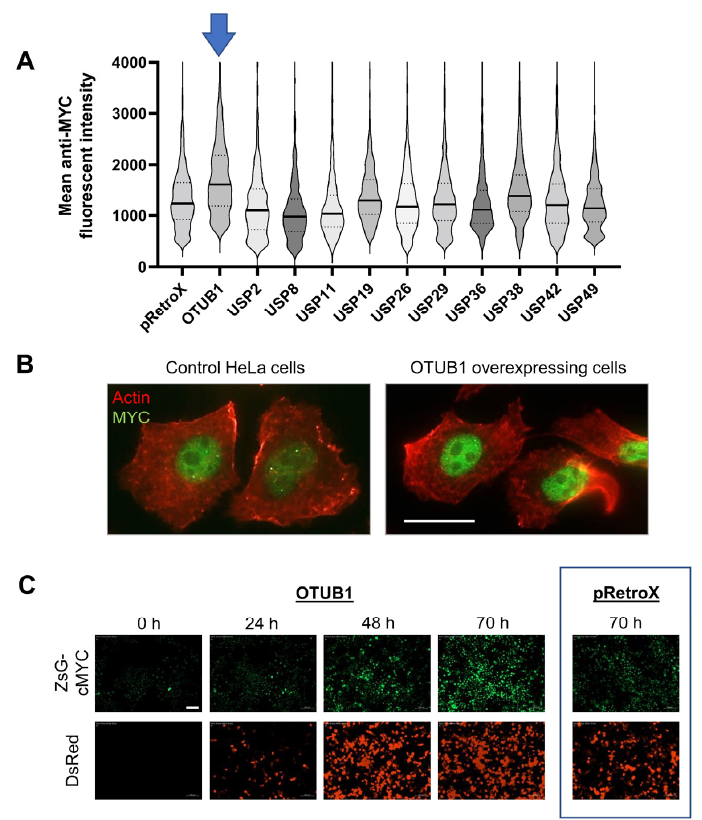
Figure 4. Validation of deubiquitinase effects on endogenous c-MYC. ( A ) Control HeLa cells were individually transfected for 48 h with the eleven deubiquitinating enzymes from the previous screen, and expression of endogenous c-MYC was quantified by immunofluorescence microscopy. Compared to the empty pRetroX-IRES-DsRedExpress control vector, only OTUB1 overexpression increased the levels of endogenous c-MYC substantially ( p < 1.76 × 10 − 28 by Wilcoxon rank-sum test with Bonferroni correction; median shown in bold). More than 500 cells and multiple visual fields were analyzed per condition. ( B ) Example showing 50 × magnification of control HeLa cells transfected with empty vector (left) and stained for Actin (red) or endogenous c-MYC (green). OTUB1 overexpression (right) increased c-MYC levels. Scale bar denotes 20 µ m. ( C ) Microscopy time course from the original screen in the stable ZsGreen1-c-Myc HeLa cells with expression of ZsGreen1-c-Myc fusion protein in the top panel and the OTUB1- and dsRedExpress-encoding vector in the bottom panel. Stable ZsGreen1-c-Myc cells transfected with the pRetroX-IRES-DsRedExpress empty vector are shown on the right (70 h time point